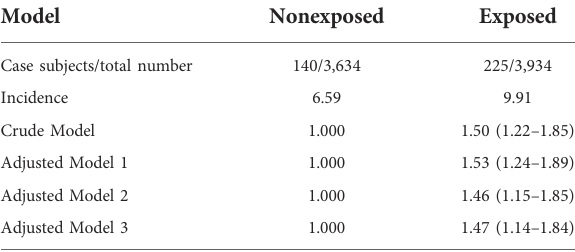
TABLE 2 Association between earthquake exposure and risk of DM in